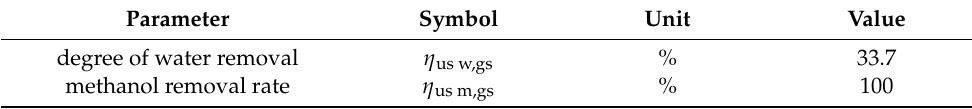
Table 8. Technological assumptions for the purification of raw glycerin.